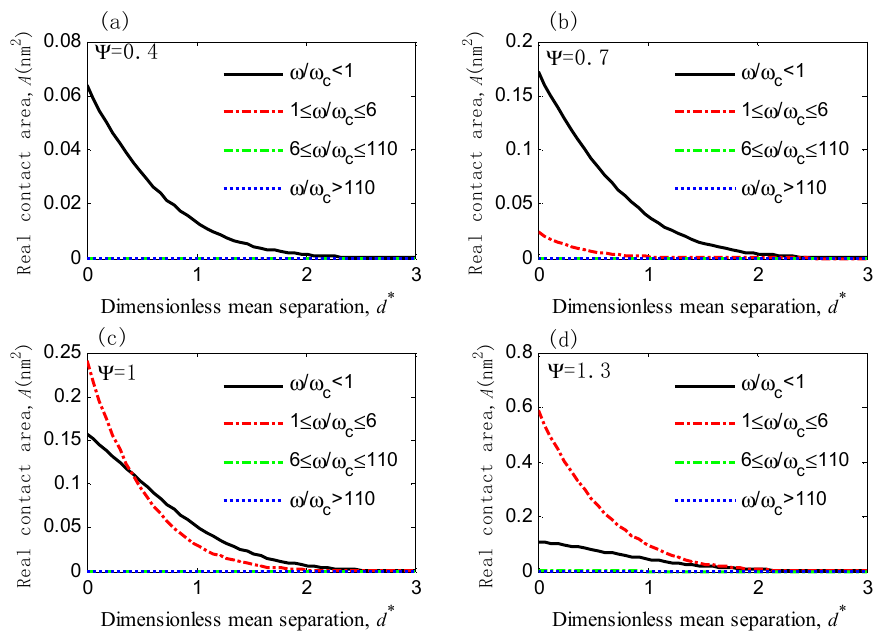
Figure 6. Real contact area of various deformation regimes versus dimensionless mean separation of asperities for different plasticity indexes (see Equation (23)): ( a ) Ψ = 0.4, ( b ) Ψ = 0.7, ( c ) Ψ = 1, ( d ) Ψ = 1.3.